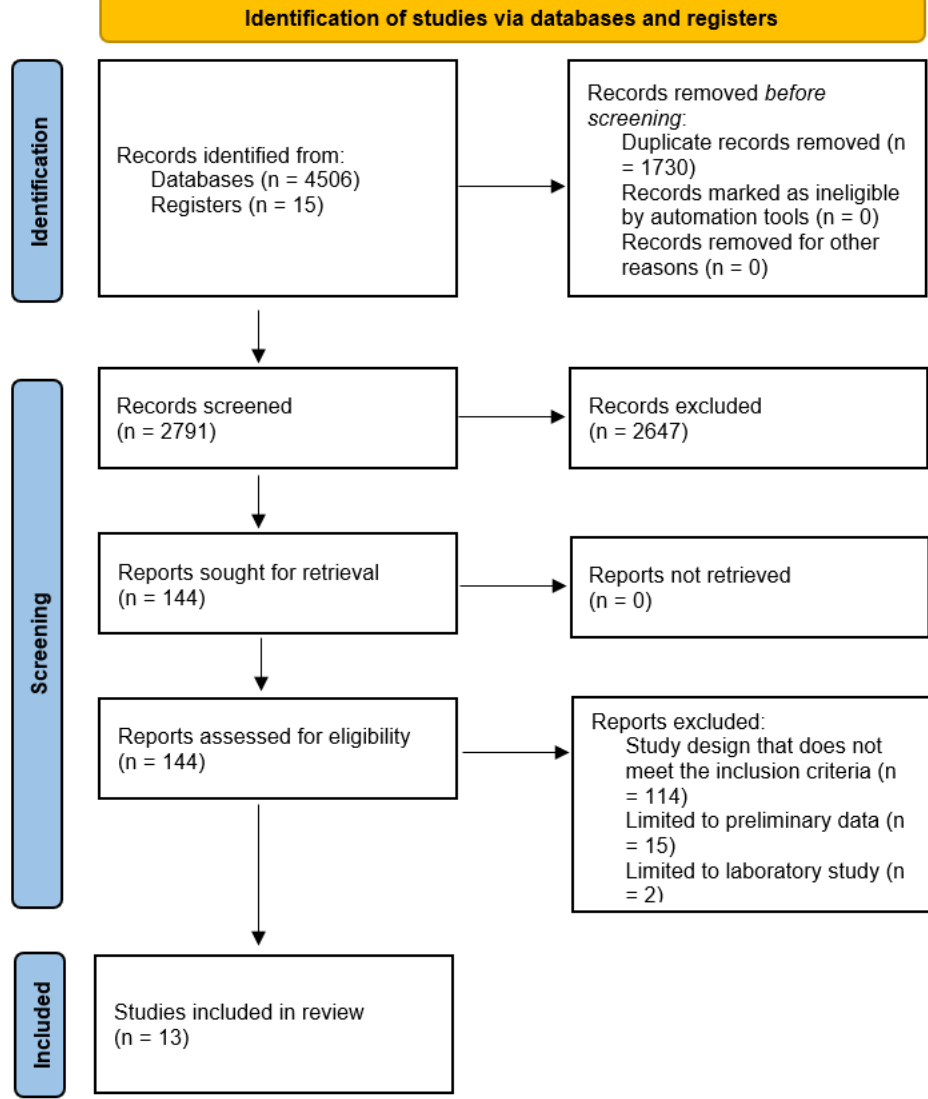
Figure 1. Search strategy flowchart.